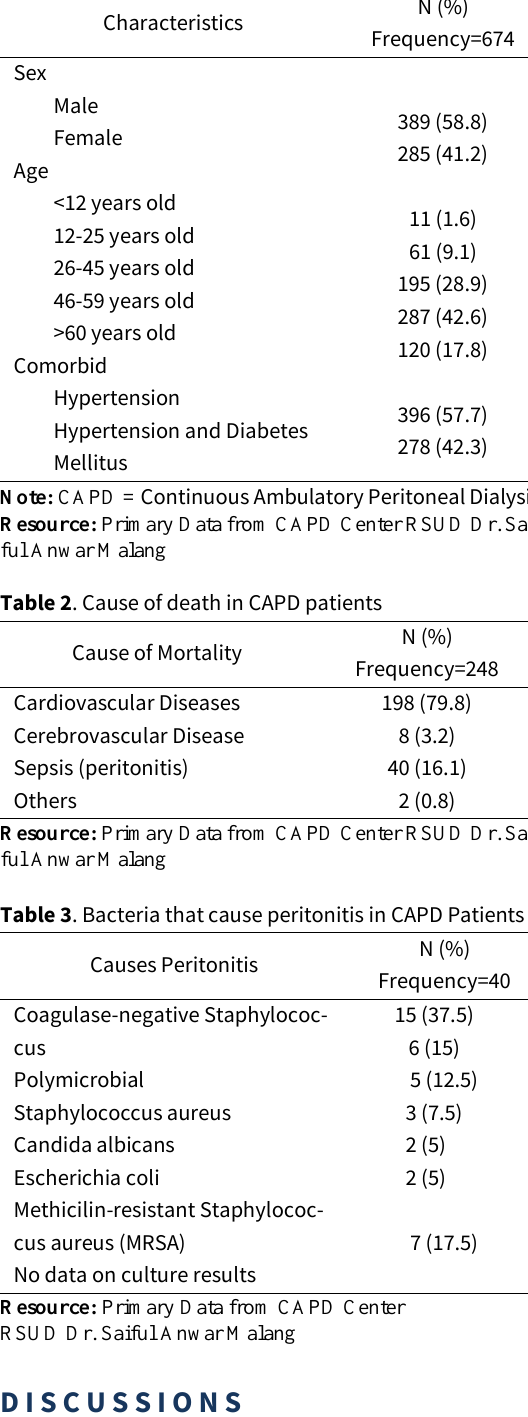
Table 1 . Characteristics of CAPD Patient in